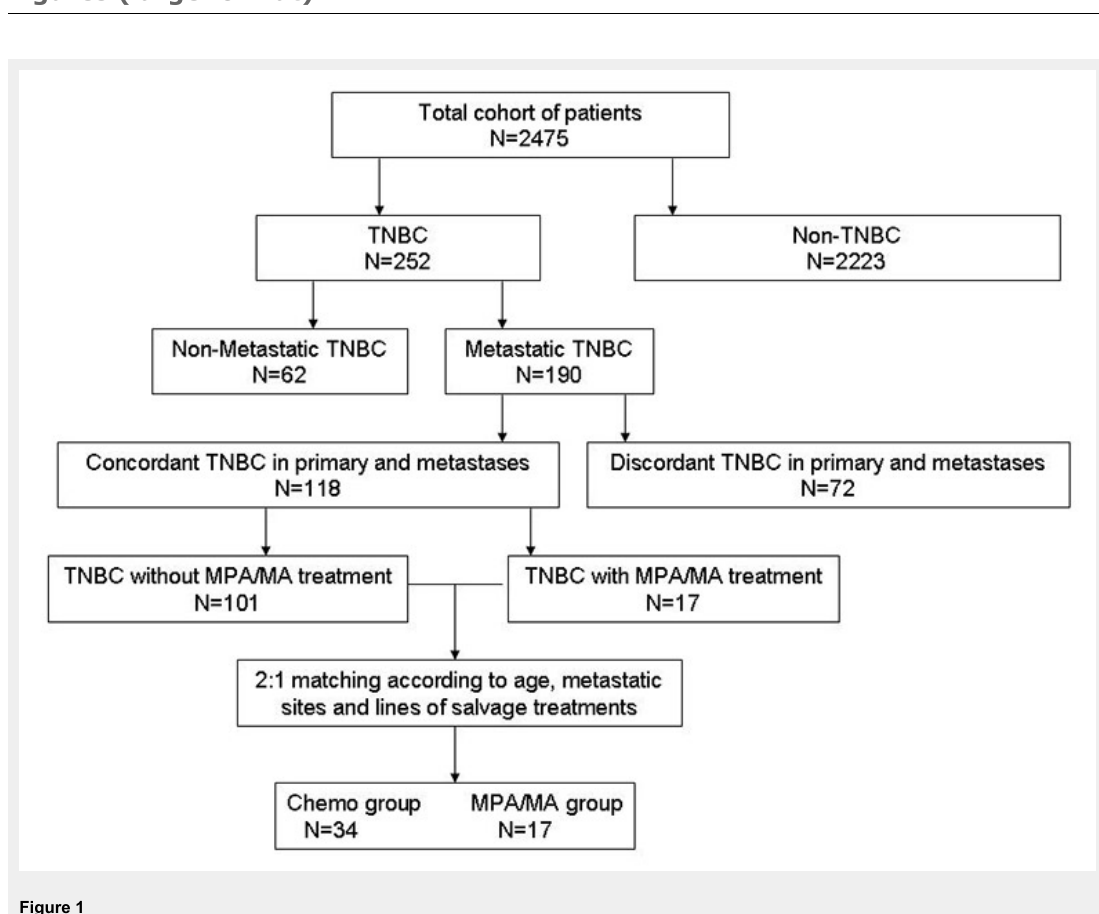
Figure 1 Flow chart of patient selection. TNBC, triple-negative breast cancer; MPA/MA, medroxyprogesterone acetate/megestrol